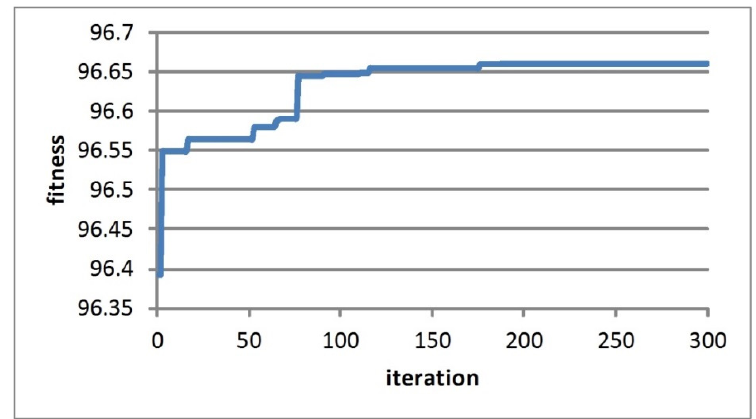
Figure 11. Convergence